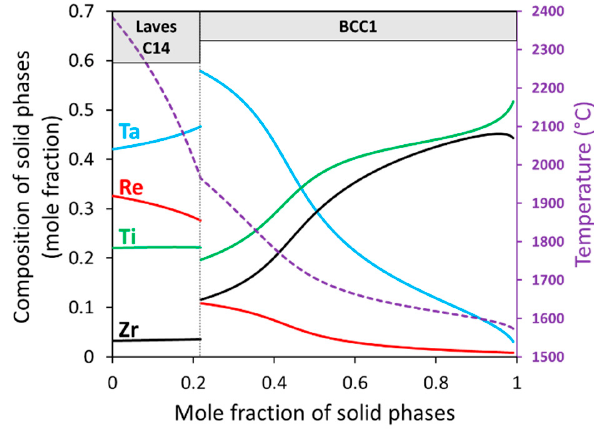
Figure 17. Compositions of Laves (C14) and BCC1 phases (colored, labeled lines) as a function of the total mole fraction of solid phases during non-equilibrium solidification (Scheil model), predicted using Thermo-Calc and the TCHEA4.1 databases. After the primary solidification of Laves C14 phase, a composition gradient forms in the BCC1 phase as the solidification progresses. The temperature dependence of the total fraction of solid phases during solidification is also shown as a dashed line.